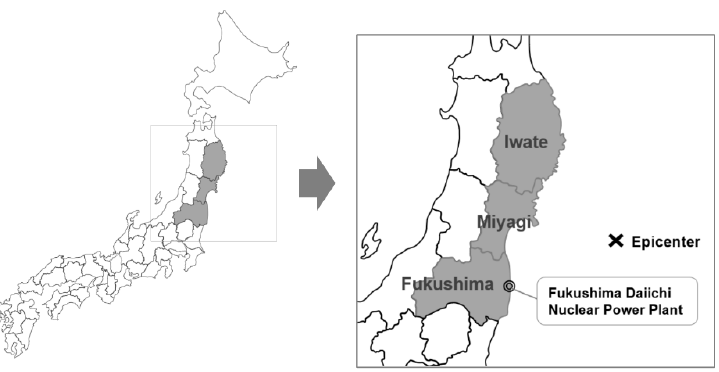
Figure 2. Location of the Fukushima, Miyagi, and Iwate prefectures, which were severely affected by the Great East Japan Earthquake.